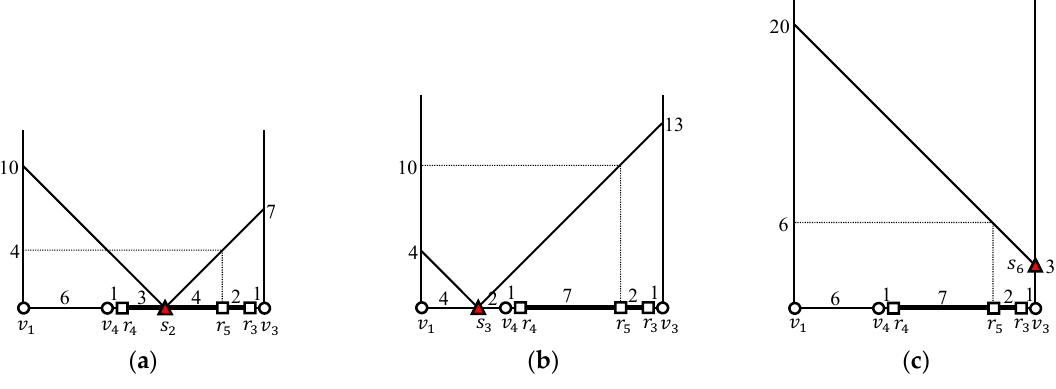
Figure 14. Computation of the distance from (cid:1870) (cid:2873) to (cid:1871) ∈ {(cid:1871) (cid:2870) ,(cid:1871) (cid:2871) ,(cid:1871) (cid:2874) } ( a ) (cid:1856)(cid:1861)(cid:1871)(cid:1872)((cid:1870) (cid:2873) ,(cid:1871) (cid:2870) ) = 4 ; ( b ) (cid:1856)(cid:1861)(cid:1871)(cid:1872)((cid:1870) (cid:2873) ,(cid:1871) (cid:2871) ) = 10 ; ( c ) (cid:1856)(cid:1861)(cid:1871)(cid:1872)((cid:1870) (cid:2873) ,(cid:1871) (cid:2874) ) = 6 .